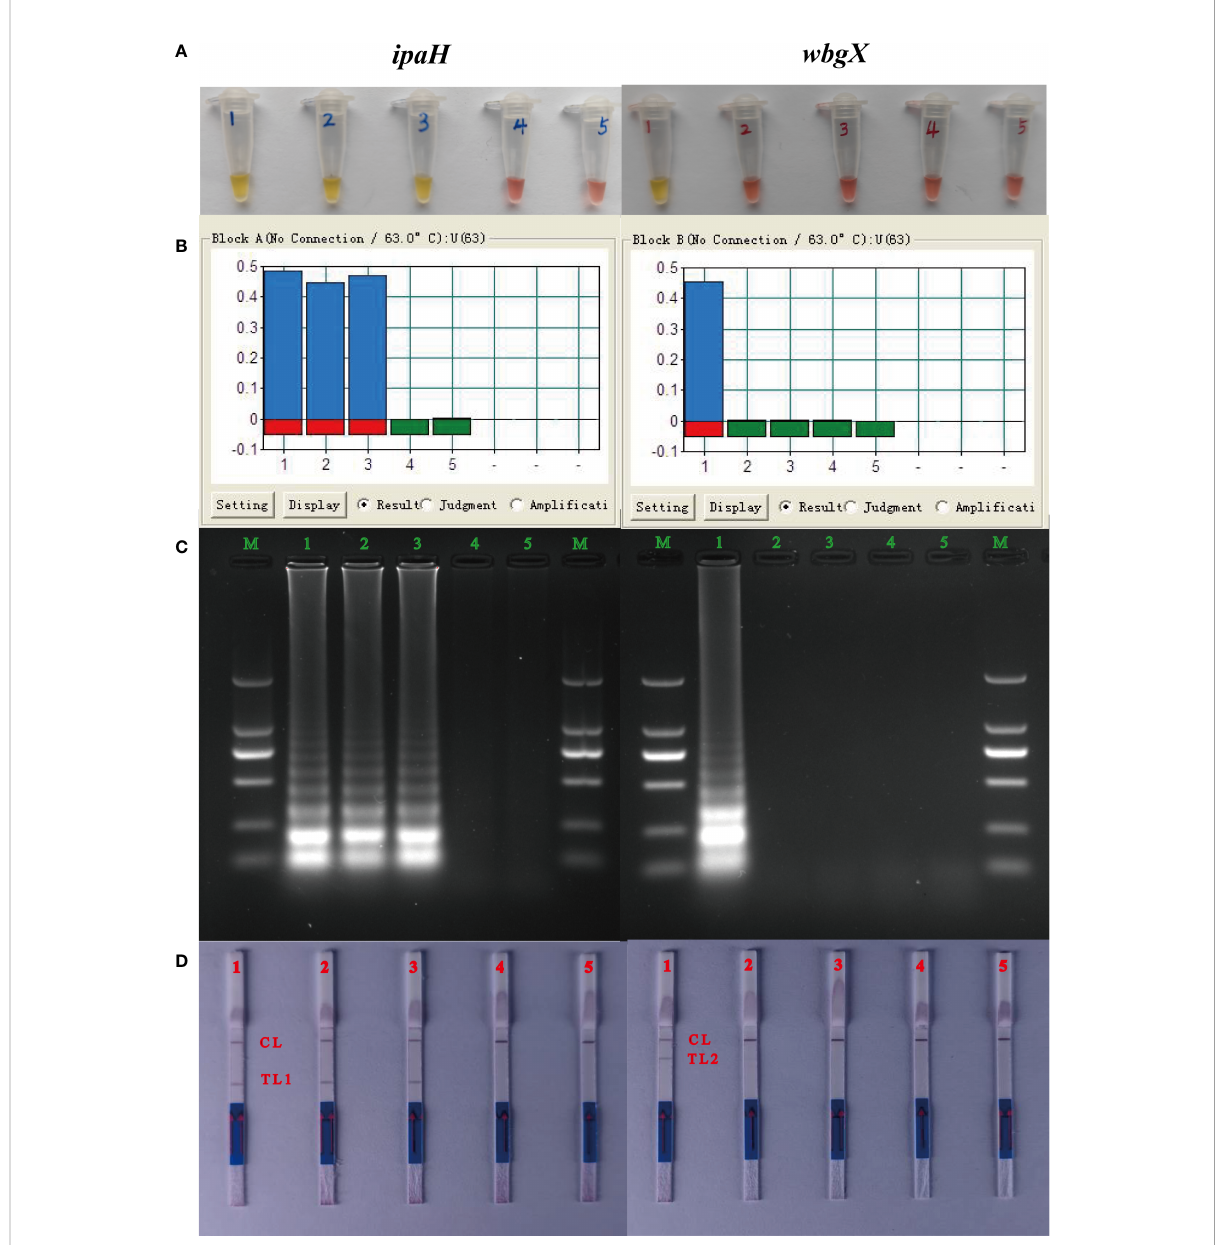
FIGURE 1 Veri fi cation of the MCDA products of ipaH and wbgX genes. Tubes/lanes/strips/biosensors 1-5: 1, S. sonnei CMCC 51081 (phase I); 2, S. fl exneri 301; 3, S. sonnei CMCC M6381 (phase II); 4, enterohemorrhagic E. coli EDL933 (Negative control); 5, distilled water (Blank control). (A) Reaction products of the MCDA assay of ipaH and wbgX genes were visually detected by color change. (B) Turbidity in real-time using the Loopamp Real-time Turbidimeter LA-320C for the MCDA assay. (C) 2% agarose gel electrophoresis results of the MCDA assay. (D) LFB was applied for visual detection of the MCDA assay, CL (control line), T L1 (test line 1), and T L2 (test line 2). For ipaH gene, positive results were observed with Tubes 1-3 with the color changed from pink to yellow, lanes 1-3 with >0.1 turbidity changes with turbidimeters, strips 1-3 with the ladder DNA amplicons, and biosensors 1-3 with the red test line 1. Negative results were observed with Tubes/lanes/strips/biosensors 4-5 with negative control and blank control. For wbgX gene, positive results were observed with Tubes/lanes/strips 1 and biosensors 1 with the red test line 2, Negative results were observed with Tubes/lanes/strips/biosensors